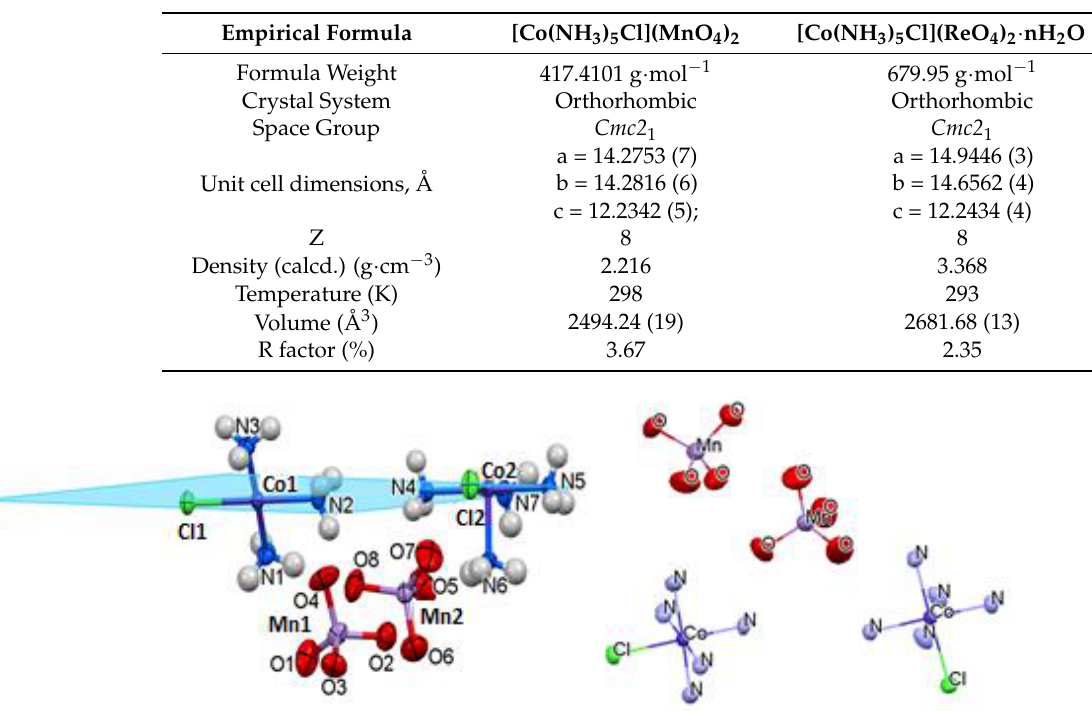
Table 2. Crystal data of compound 3-M .